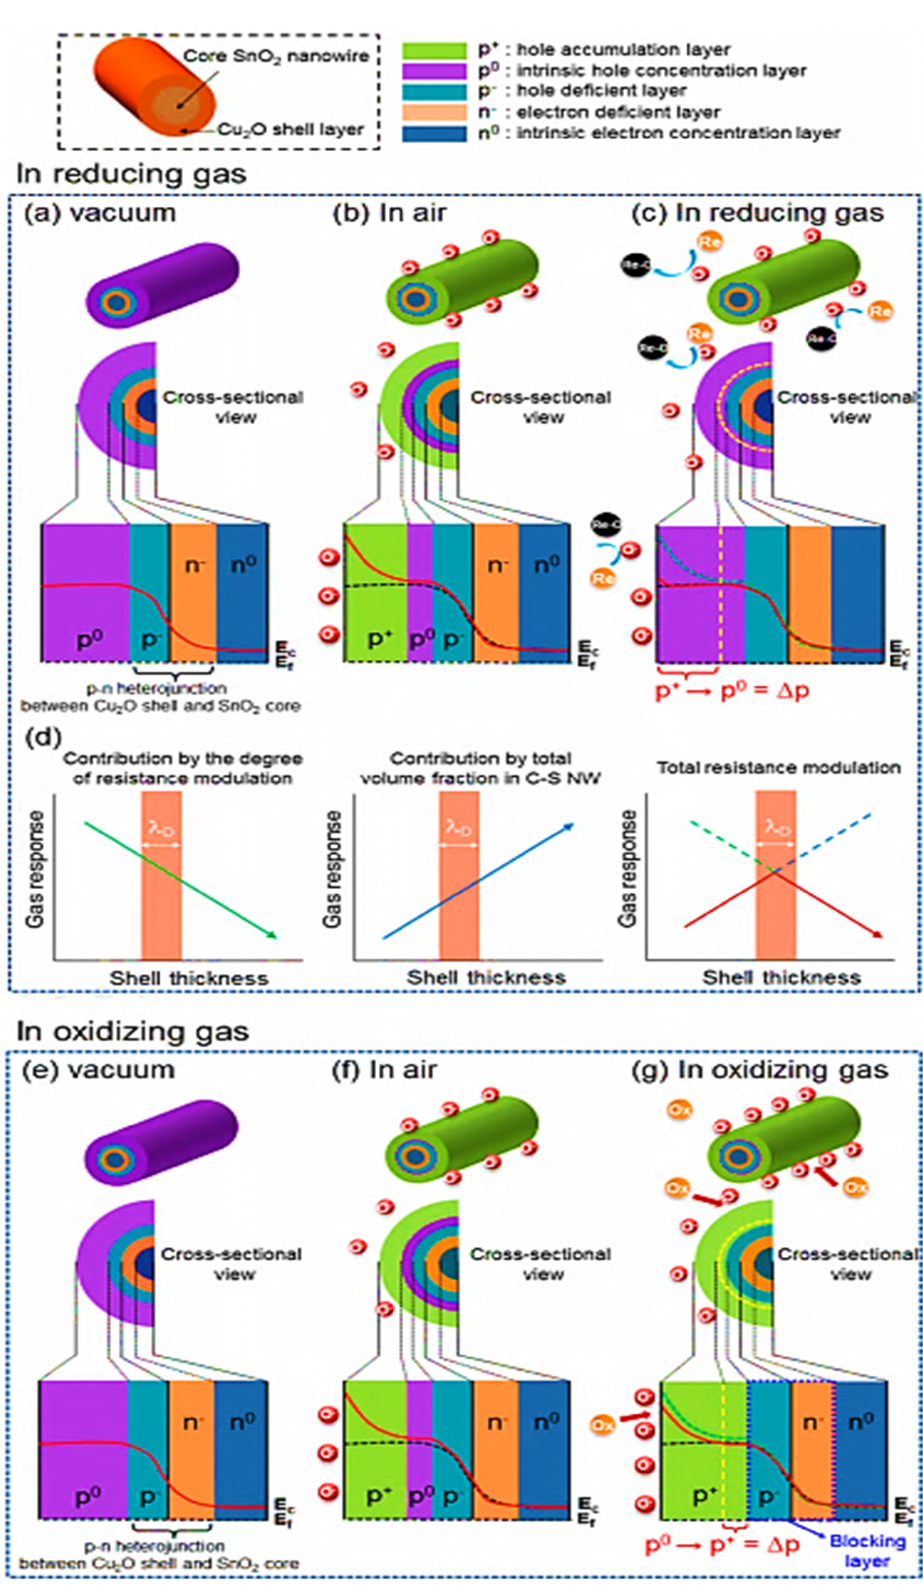
Figure 8. Conceptual explanation of the sensing mechanism in the SnO 2 − Cu 2 O C-S NWs; ( a ) in vacuum, ( b ) in air, and ( c ) in the presence of reducing gases, and ( d ) overall modulation of the resistance. The sensing mechanism for oxidizing gases in ( e ) vacuum, ( f ) air, and ( g ) oxidizing gases. Reproduced from [79] with the permission of the American Chemical Society.